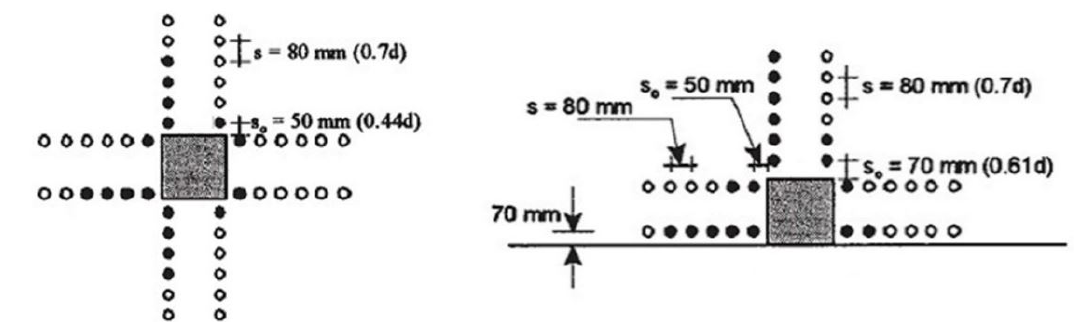
Figure 4.S hear reinforcement for slab S2 of Sherif and Dilger